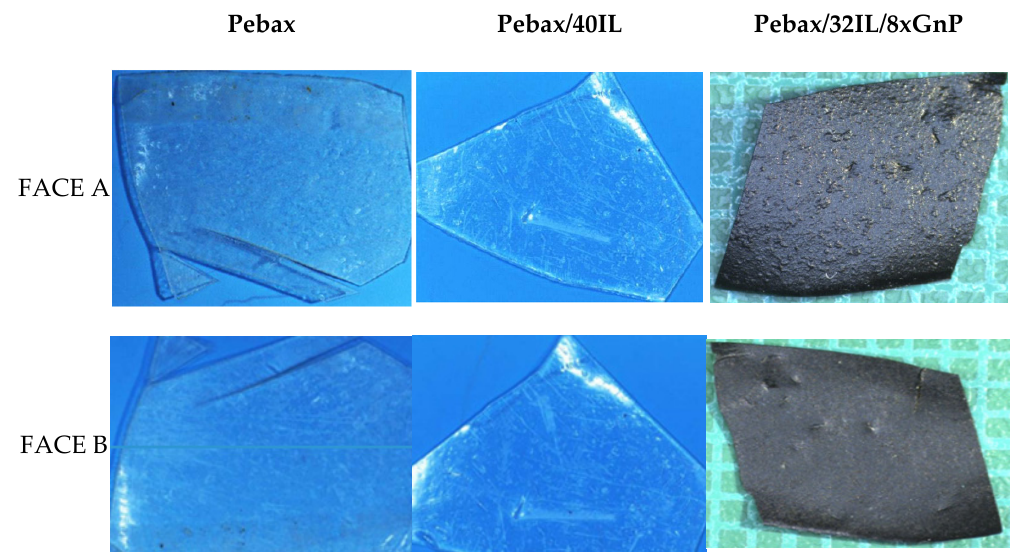
Figure 8. 2D imaging with optical reflection (14.5 × 10.5 mm 2 ) of rough face A and face B of Pebax, Pebax/40IL; and Pebax/32IL/8xGnP (full names in Table 1).